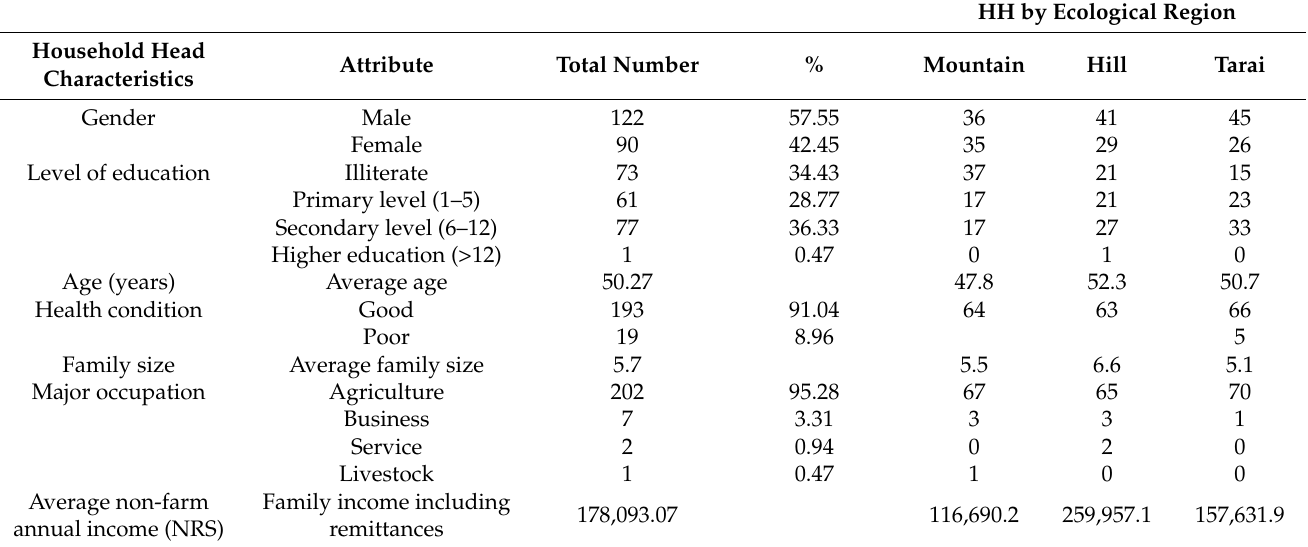
Table 2. Household demography and characteristics of the farmers surveyed in GRB.